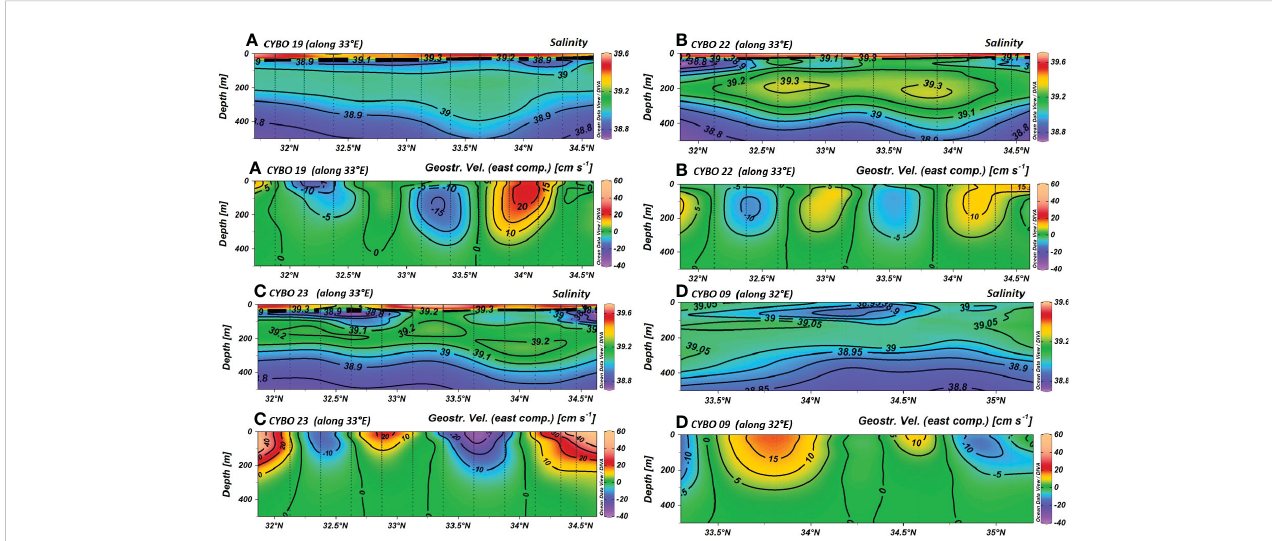
FIGURE 9 North-south cross sections along the 33°E meridian (see Figure 3) of salinity (top) and the eastward component of the geostrophic velocity (bottom) during: (A) CYBO 19 cruise (Sept 2005); (B) CYBO 22 cruise (Aug 2009); (C) CYBO 23 cruise (Aug 2010); (D) CYBO 9 cruise (May 2000). Positive geostrophic velocities indicate eastward fl ow, while negative velocities indicatewestward fl